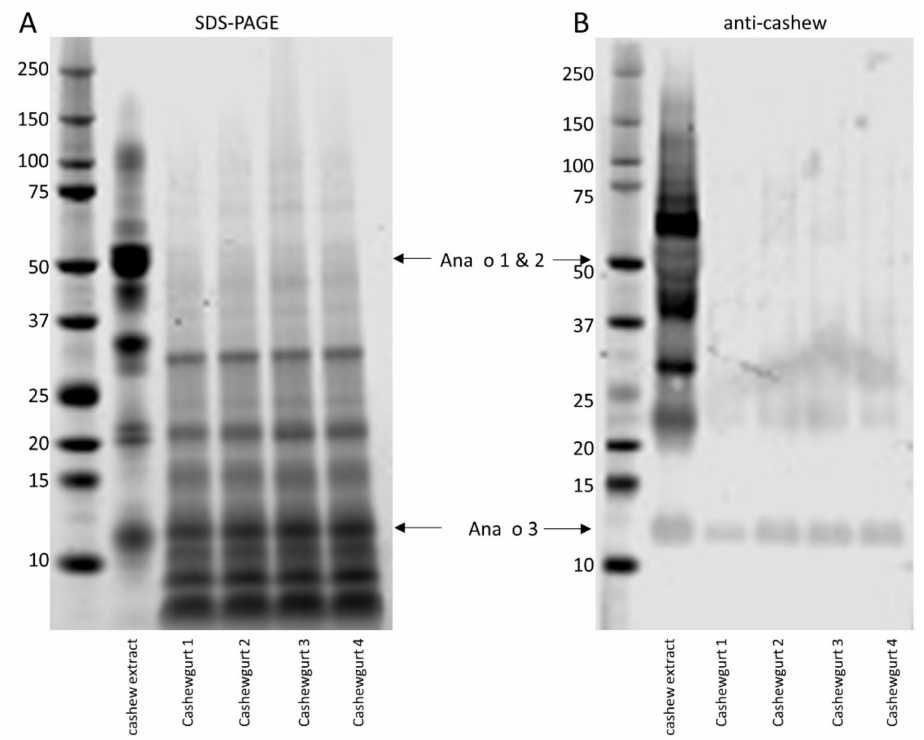
Figure 1. Comparison of soluble cashew nut extract and Cashewgurt protein. Non-reducing SDS-PAGE analysis of soluble cashew nut and Cashewgurt protein extracts ( A ) and immunoblot of identical material with a rabbit polyclonal antibody ( B ). Ana o 1, 2, and 3 are indicated with arrows and molecular weight standards are shown to the left of each